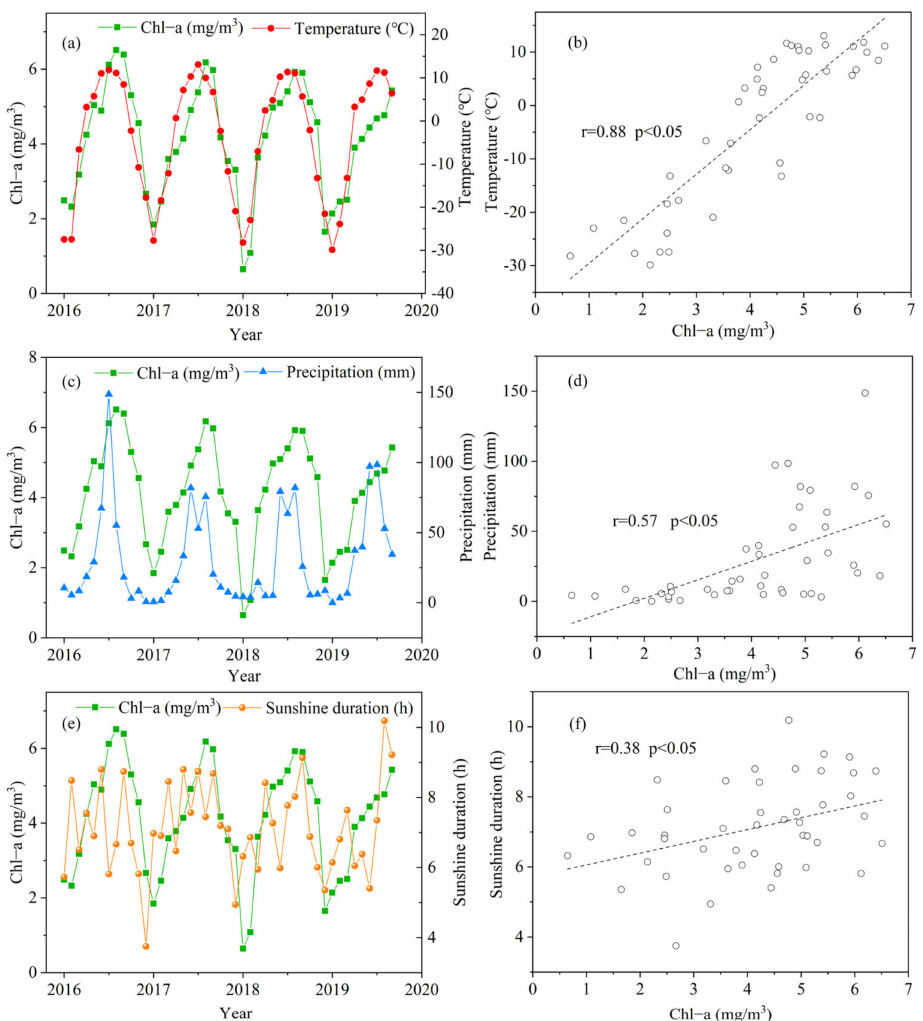
Figure 13. The temporal change of chl-a concentration and its controls, including temperature ( a ), precipitation ( c ) and sunshine duration ( e ). The ( b , d , f ) represent the correlation between chl-a and temperature, precipitation and sunshine